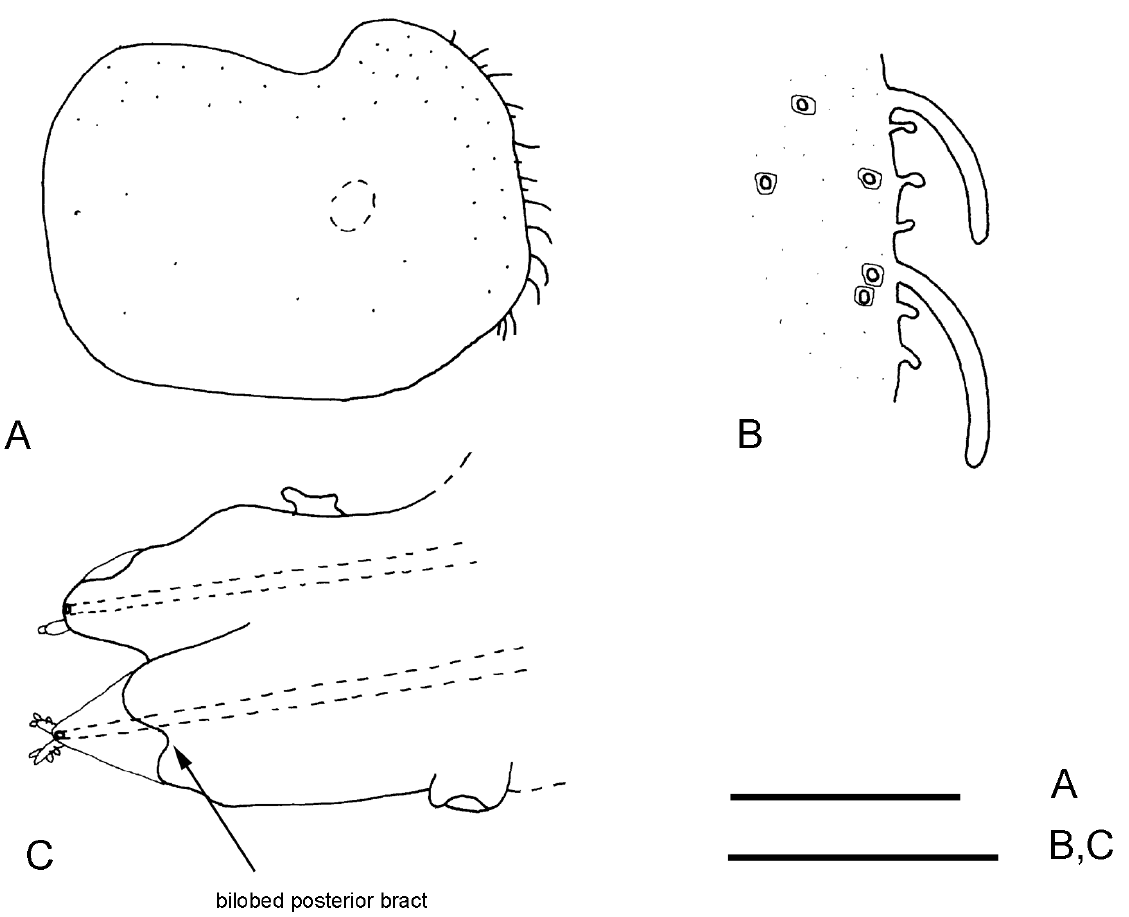
Fig. 7. Fimbriosthenelais longipinnis (Grube, 1869). SMF 10597. A . Right elytron of segment 11. B . Outer lateral margin of same. C . Left parapodium of segment 10, posterior view. Scale bars: A = 500 µm; B = 100 µm; C = 250